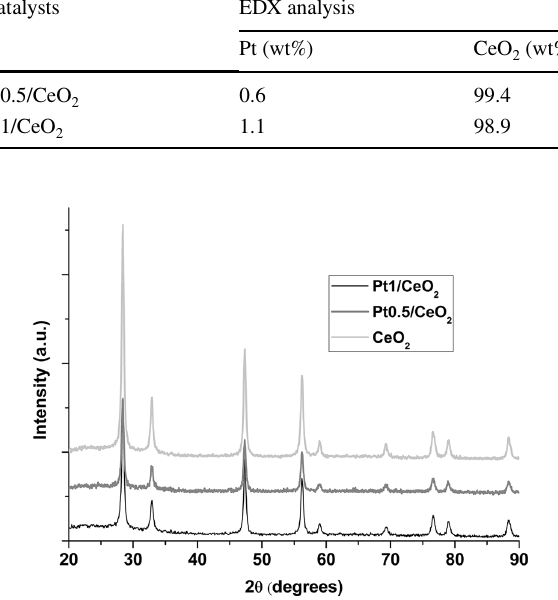
Fig. 1 X-ray diffractograms of CeO